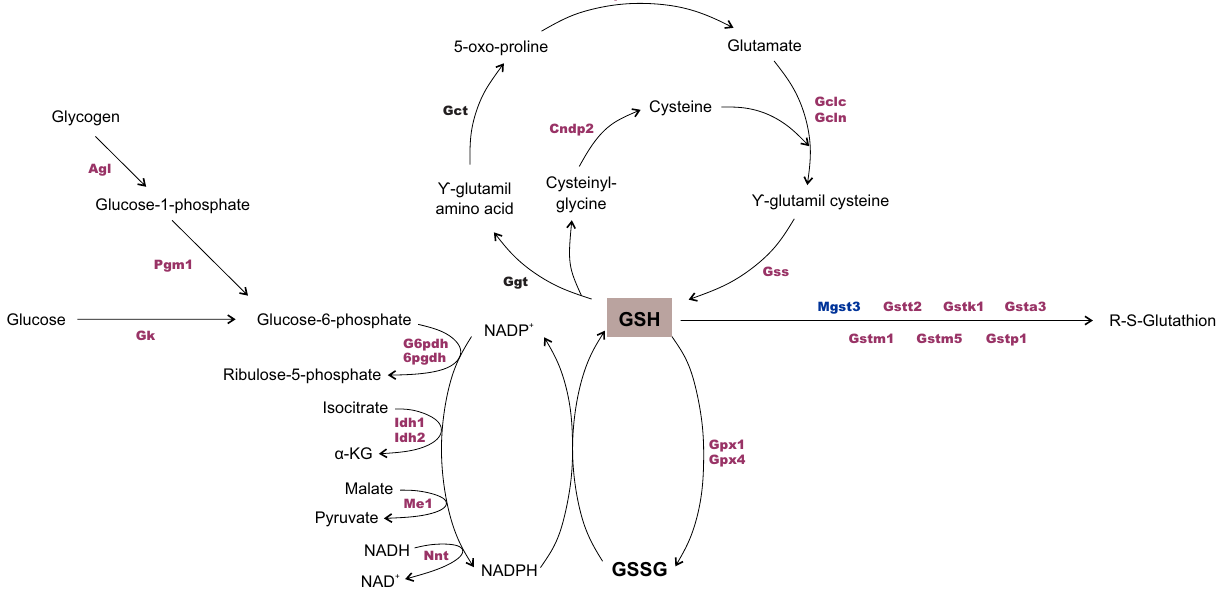
Figure 3. Glutathione metabolism. Proteomic analysis revealed prevalence of GSH synthesis and consumption in female hippocampus. The glutathione redox cycling catalyzed by GPx and GR is dependent on NADPH as a supplier of reducing equivalents, constantly regenerated mainly by pentose phosphate pathway. The differentially expressed proteins revealed by proteomics in organotypic hippocampal slice culture are highlighted in pink (increased abundance in female) and blue (increased abundance in males). For more details, see Supplementary Dataset 4. Statistical analyses were performed by using Student’s t test followed by multiple testing corrections using the Benjamini–Hochberg procedure for false discovery rate (n = 5 biological replicates, each containing 3